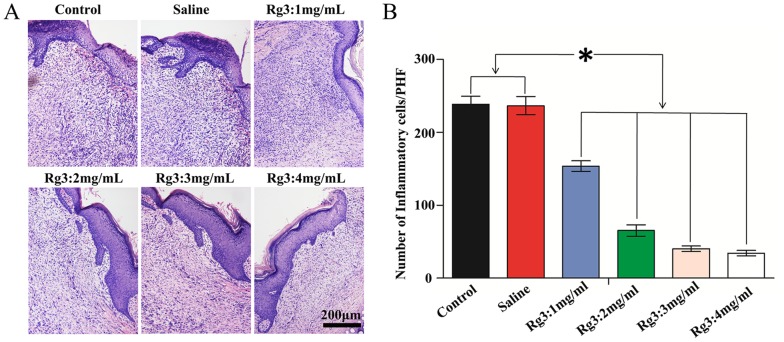
Histological observation of inflammation on day 14.(A) The inflammatory cells, granular tissue and newly formed epithelium could be observed by HE staining in each group. The Rg3 treated groups, the inflammation significantly decreased, with fewer inflammatory cells and newly-formed granular tissues density, compared with the untreated control group and the saline treated group. (HE, 100×) (B) Quantification of inflammatory cells in each group. The number of inflammatory cells in the Rg3 treated groups is lower than the control group and the saline injection group. (* indicates significant difference, p<0.05, data represent the mean ± SD of n = 9.)